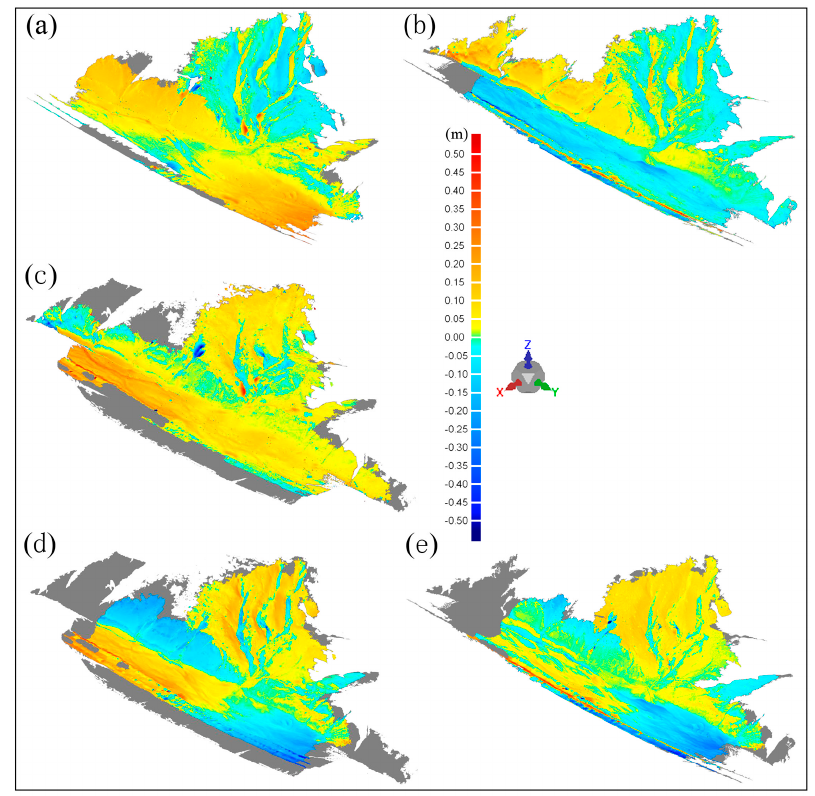
Figure 6. Map showing the topographical changes of the slope during the freeze–thaw cycles: ( a ) first thawing; ( b ) second thawing; ( c ) freezing; ( d ) one thawing and one freezing stage from May 2014 to May 2015; and ( e ) two thawing and one freezing stage from 2 May 2014 to 4 October 2015. The two red dotted lines in each figure divide the slope into three zones: upper slope (top), lower slope (center), and the base of slope (bottom).